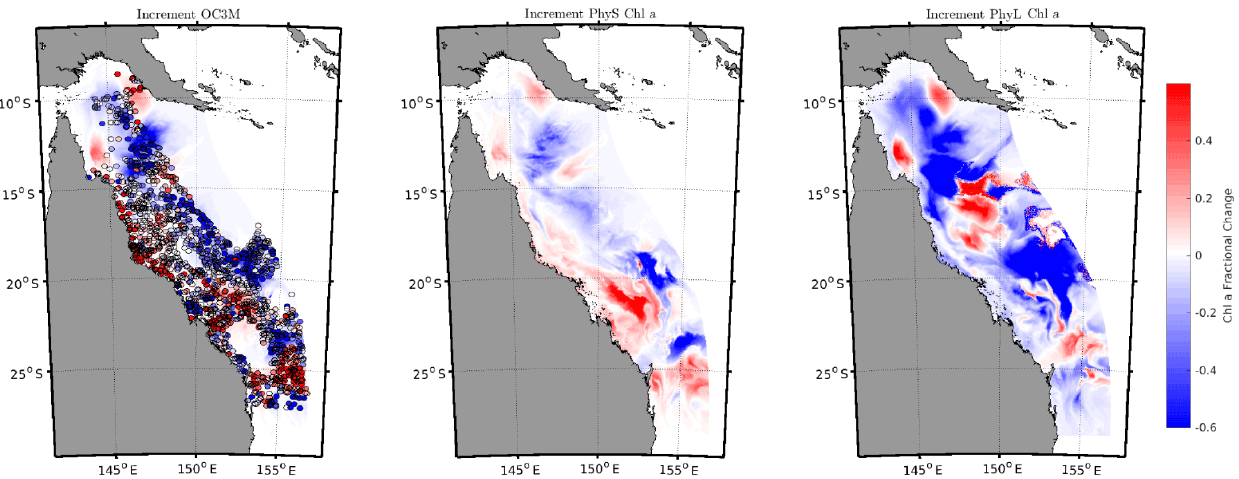
Figure 14. Increments that are added to the forecast fields generated by the assimilation system (EXP4 configuration) for simulated OC3M with innovations overlaid (left), and the prognostic variables of surface small phytoplankton Chl a (centre) and surface large phytoplankton Chl a (right) for cycle